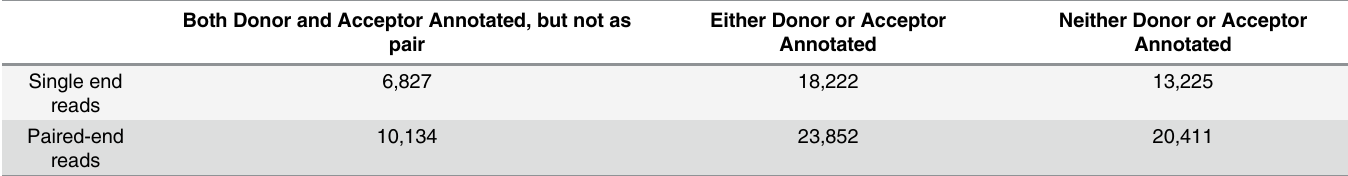
Either Donor or Acceptor Annotated